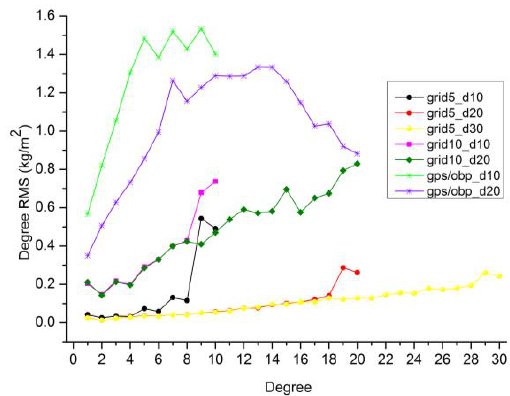
Figure 3. Degree RMS differences between coefficients inverted from various inversion schemes and reference values discussed in Section 2.1. Simulated data at global 5° × 5° (‘grid5’) and 10° × 10°